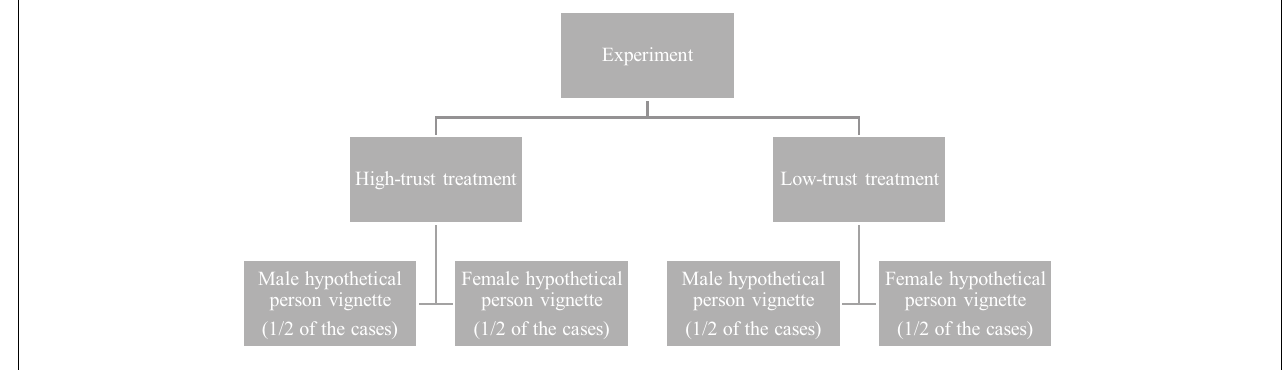
FIGURE 1 | The structure of the survey experiment. The allocation to various treatments and vignettes is randomly determined by the computer.